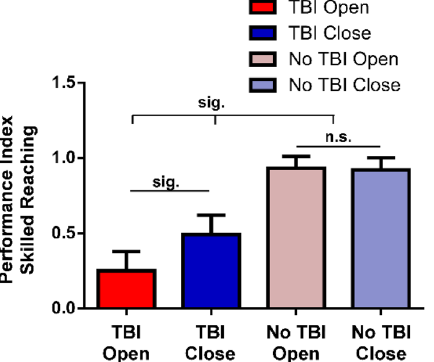
Figure 3. Treatment of cranium following a craniectomy (closed cranial repair vs. open unrepaired skull) was compared between rats having a TBI injury over forelimb motor cortex (TBI Open Skull Group and TBI Closed Skull Group) to rats that had the same craniectomy but no injury (No TBI Open Skull Group and No TBI Closed Skull Group). Rats were assessed over 16 weeks after the craniectomy (once per week for the first month